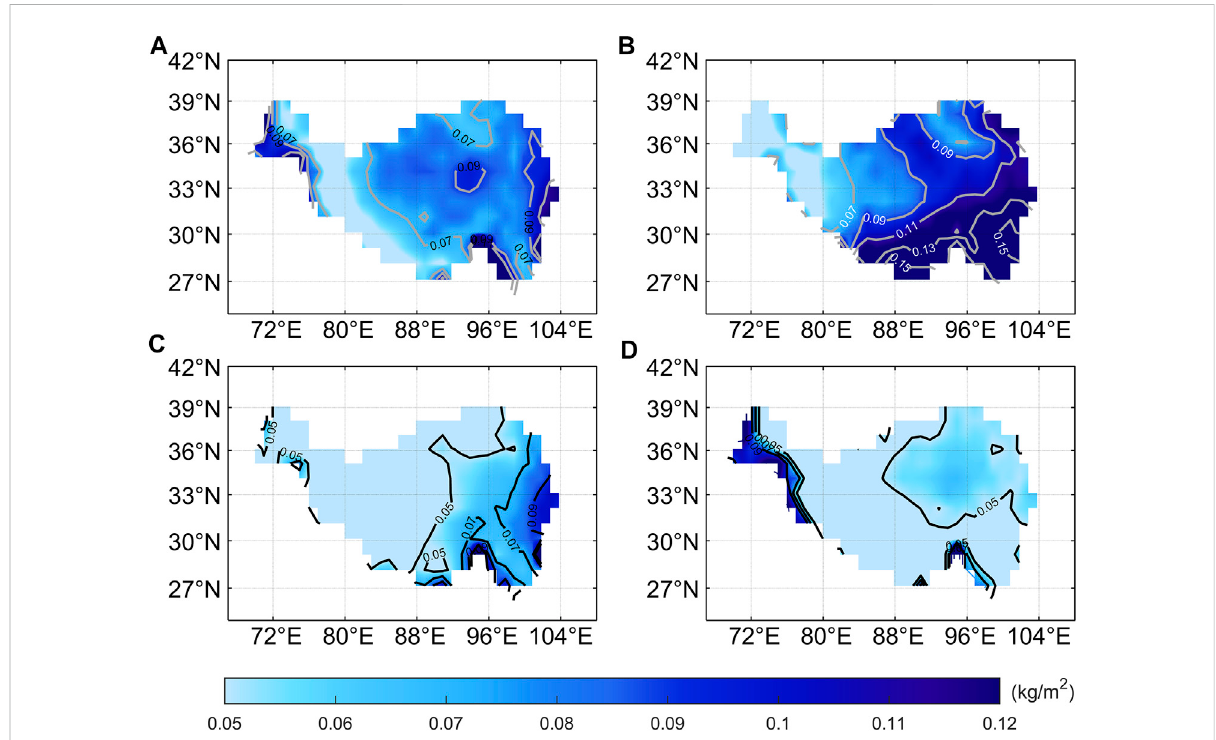
Spatial distributions of atmospheric ice over the TP in the different seasons given by ERA5 from 2003 to 2020. (A) Spring (MAM), (B) summer (JJA), (C) autumn (SON), and (D) winter (DJF).